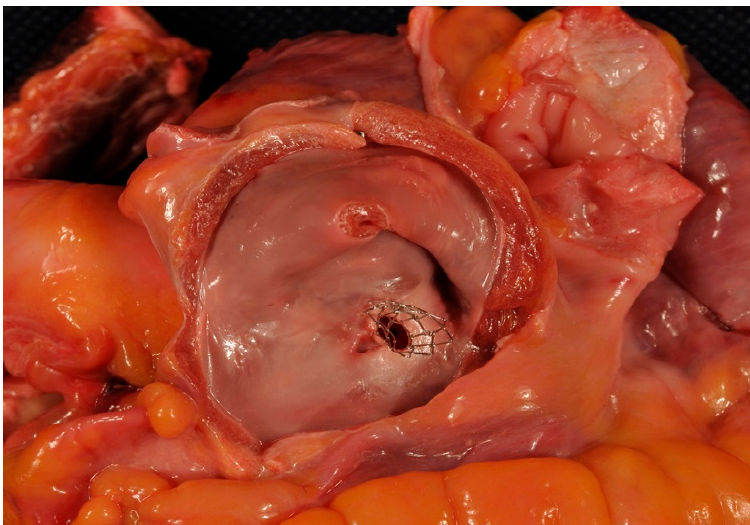
Figure 4. Autopsy of the patient that died of pulmonary hypertensive crisis developed after cardiac catherization at 5 years after AS. Left atrium is opened. Full patent stent is seen.